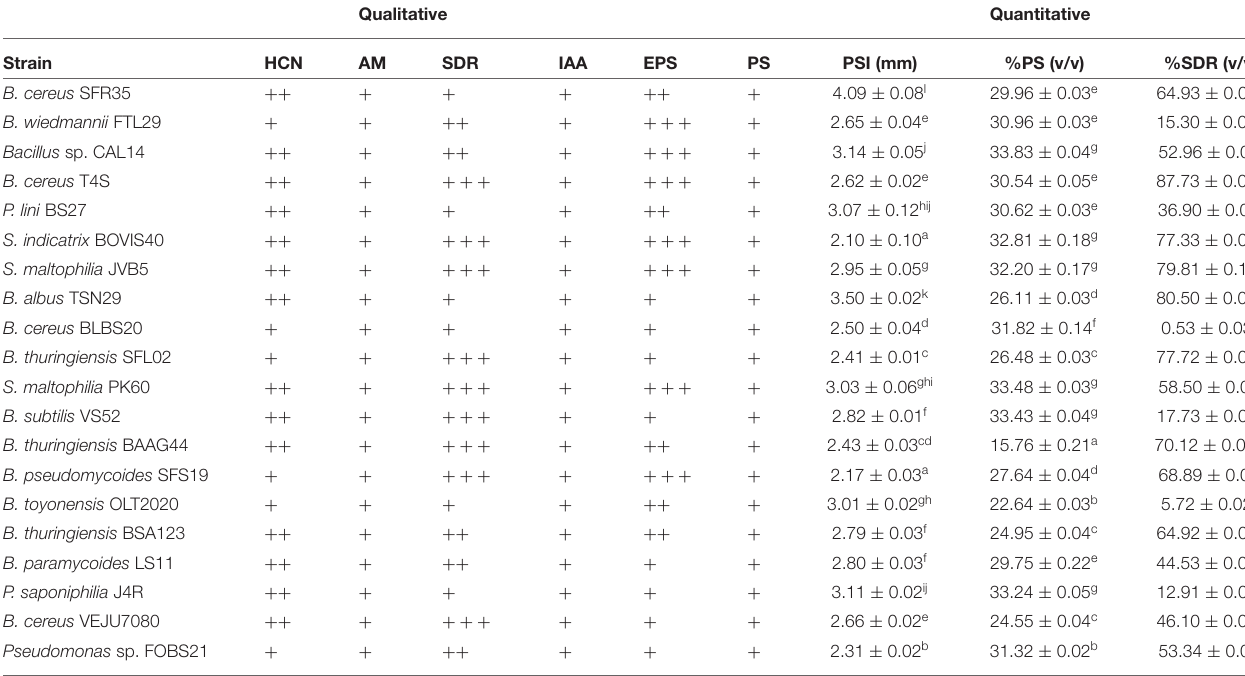
TABLE 3 | Plant growth-promoting traits of endophytic